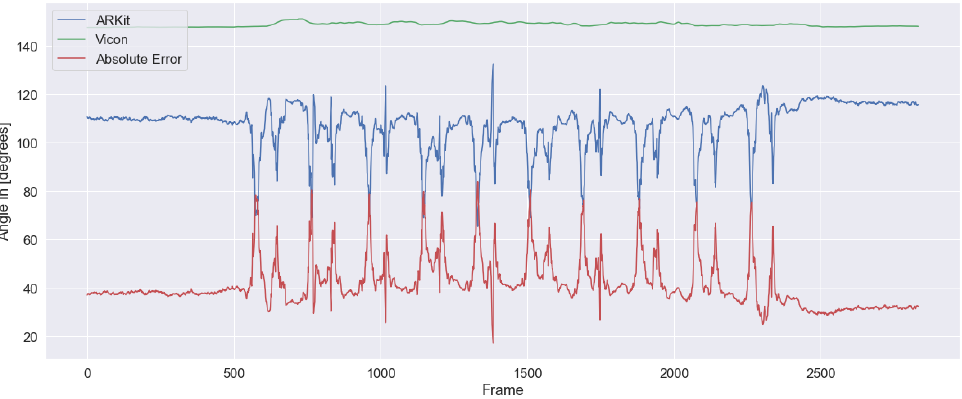
Figure 8. Right elbow angle of one of the subjects in the Squat exercise in degrees, which shows bad tracking quality with a lot of noise compared to the Vicon